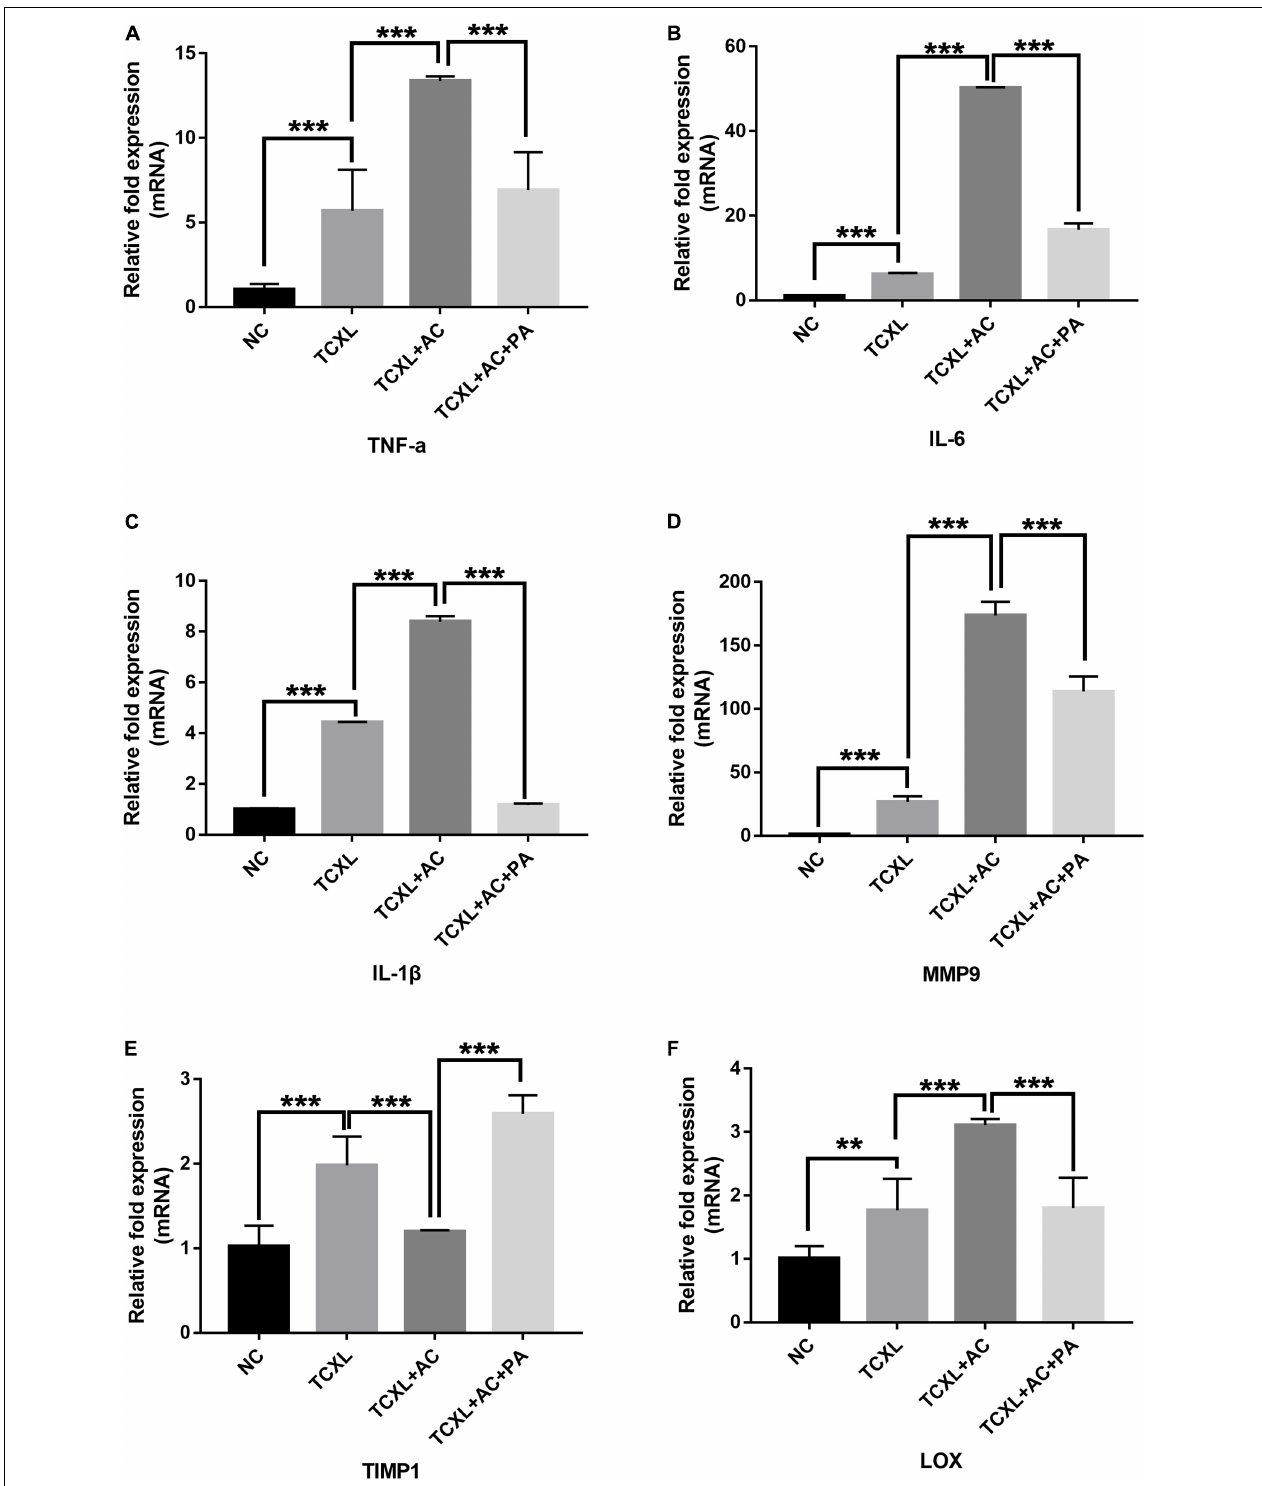
FIGURE 2 | Quantitative analysis of TNF- α (A) , IL-6 (B) , IL-1 β (C) , MMP9 (D) , LOX (E) , and TIMP-1 (F) mRNA transcripts in the corneal stroma on D28. The mRNA levels of TNF- α , IL-6, IL-1 β , and MMP-9 were significantly increased in the TCXL + AC group when compared with the TCXL and TCXL + AC + PA groups. In contrast, the TIMP-1 level was significantly lower in the TCXL + AC group when compared with the TCXL and TCXL + AC + PA groups. Data are presented as mean ± SD, n = 6/group (** P < 0.01; *** P < 0.001).